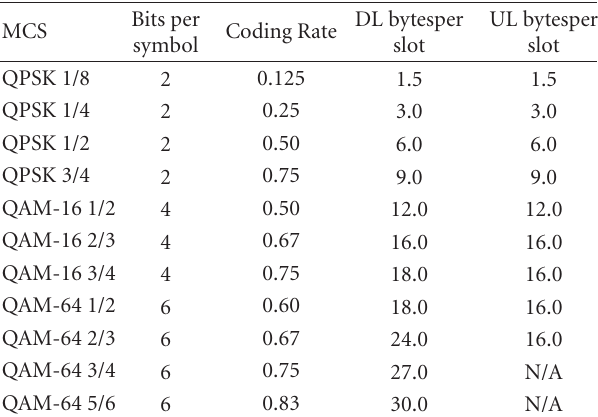
Table 3: Slot capacity for various